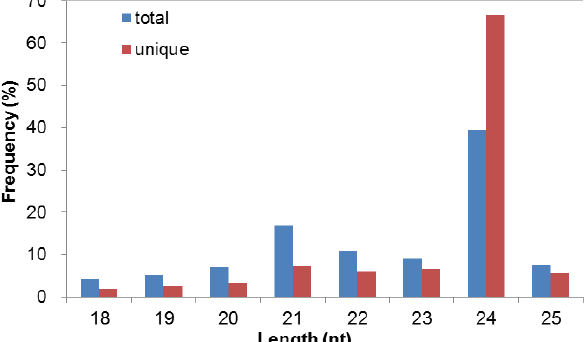
Figure 1. Length distribution of small RNAs in the library of A. membranaceus . X -axis, size group of small RNA; Y -axis, corresponding percentage of raw reads.